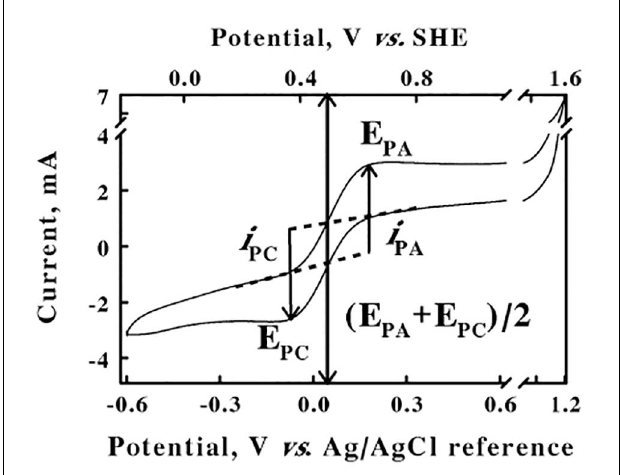
FIGURE 1 | Calibration of the silver/silver chloride reference electrode. Cyclic voltammetry was conducted at a scan rate of 256 mV/s on a mixture of 25 mM each of ferri- and ferrocyanide in water. E PA , E PC , and (E PA + E PC )/2 represent the potentials for the anodic and cathodic peaks and the ferri-/ferrocyanide couple, respectively; i PA and i PC represent the currents for the anodic and cathodic peaks, respectively. SHE represents the reduction potential for the standard hydrogen